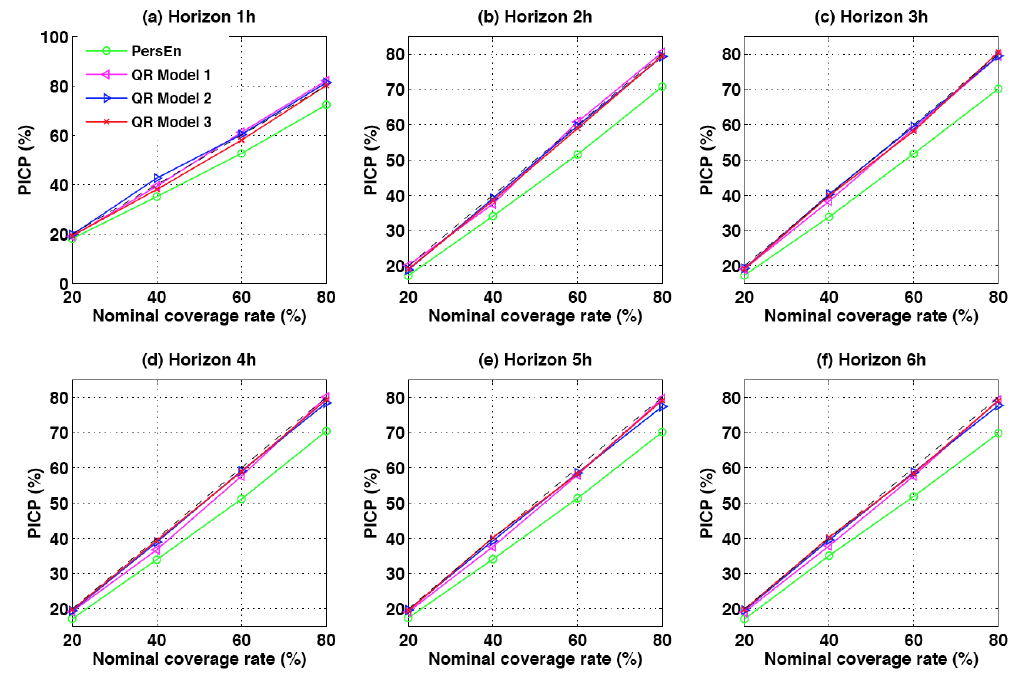
Figure 5. PICP for different nominal coverage rates and forecast horizons (site of Le Tampon). The dotted black line represents the ideal case. ( a ) Horizon 1 h; ( b ) Horizon 2 h; ( c ) Horizon 3 h; ( d ) Horizon 4 h; ( e ) Horizon 5 h; ( f ) Horizon 6